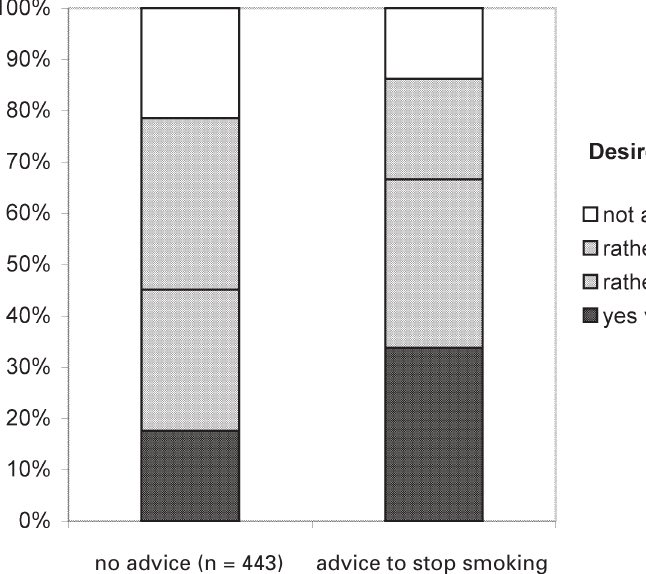
Presence of the desire to stop smok- ing in relation to physician’s advice (n = 683, only current regular